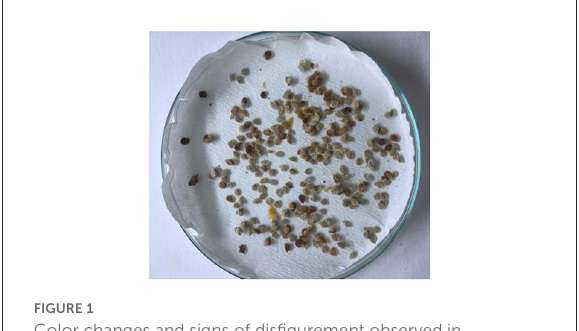
FIGURE1 Color changes and signs of disfigurement observed in tomato seeds.